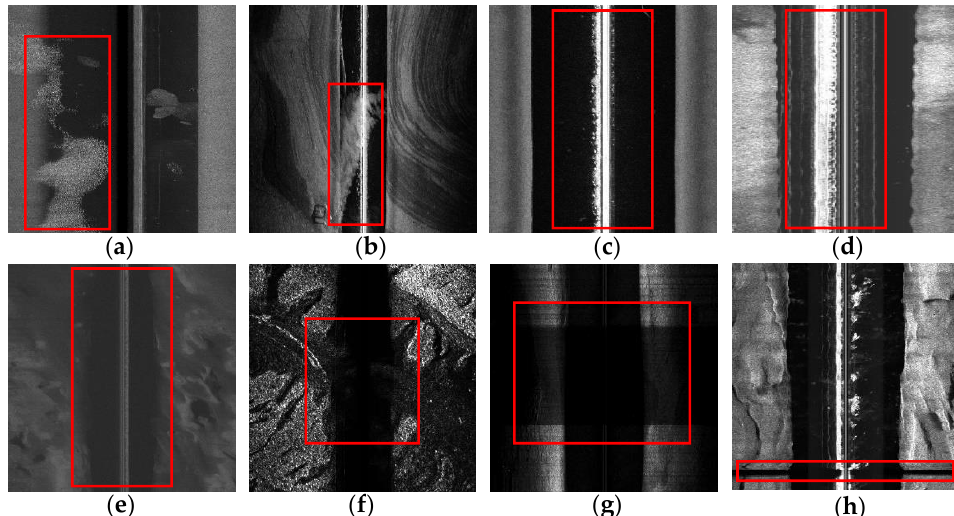
Figure 2. Influencing factors of FBR detection in SSS data. ( a , b ) Suspended solids. ( c ) Ship wake. ( d ) Sound reflection from sea surface. ( e ) Water with high turbidity. ( f ) Strong absorption sediments. ( g ) Varying gains. ( h ) Missing pings.